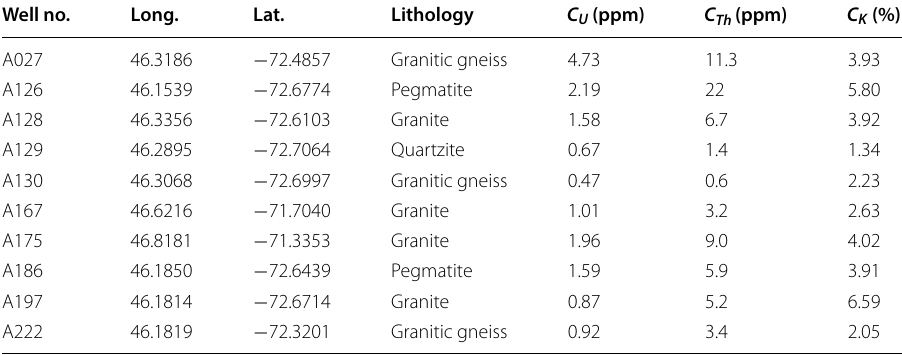
Table 2 Concentration of radiogenic elements for basement rocks obtained from wells located south of Trois–Rivières from ICP–MS and ICP–OES analyses undertaken in our study Well